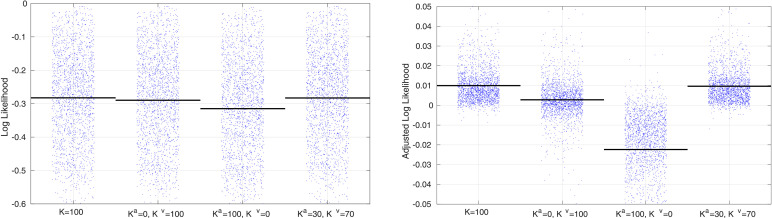
Cross-validation accuracy measures based on predicting the left-out patches of the images using different model configurations. The blue dots show the mean value for each of the 1913 images, whereas the horizontal bars show the mean values overall. The plot on the left shows mean log-likelihoods over the pixels in each patch, wheres the plot on the right shows the log-likelihoods after subtracting the mean – over model configurations – for each patch.